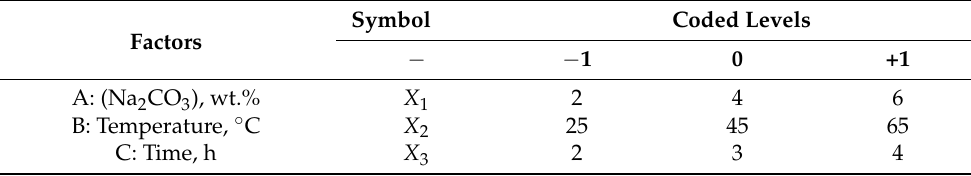
Table 1. Coded and real levels of the factors using central composite design for CEC. Symbol Coded Factors